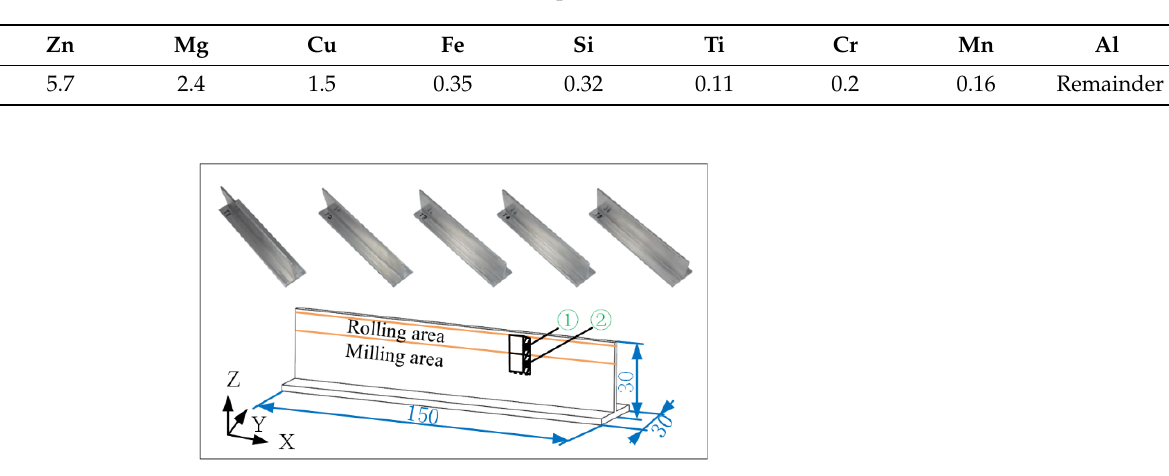
Figure 1. Samples used in the test.